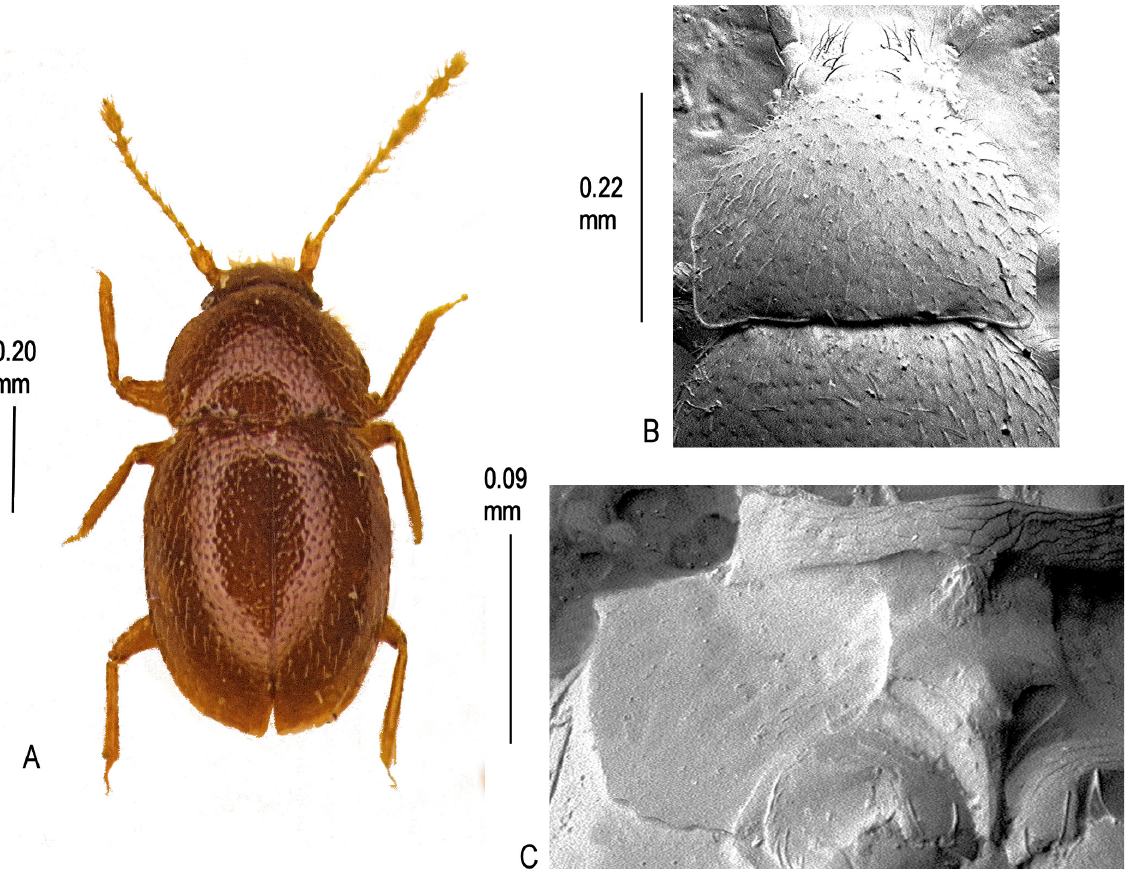
Fig. 73 . Cissidium insulare sp. nov. A . Habitus. B . Pronotum, × 315. C . Mesoventrite showing median process of collar, lateral margin, mid-keel and keel, ×